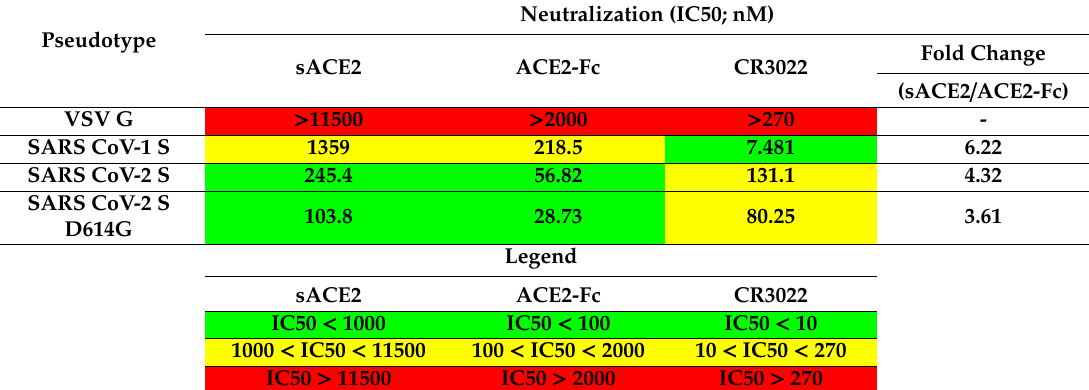
Table 1. Neutralization half-maximal inhibitory concentrations (IC 50 ). VSV-G—vesicular stomatitis virus